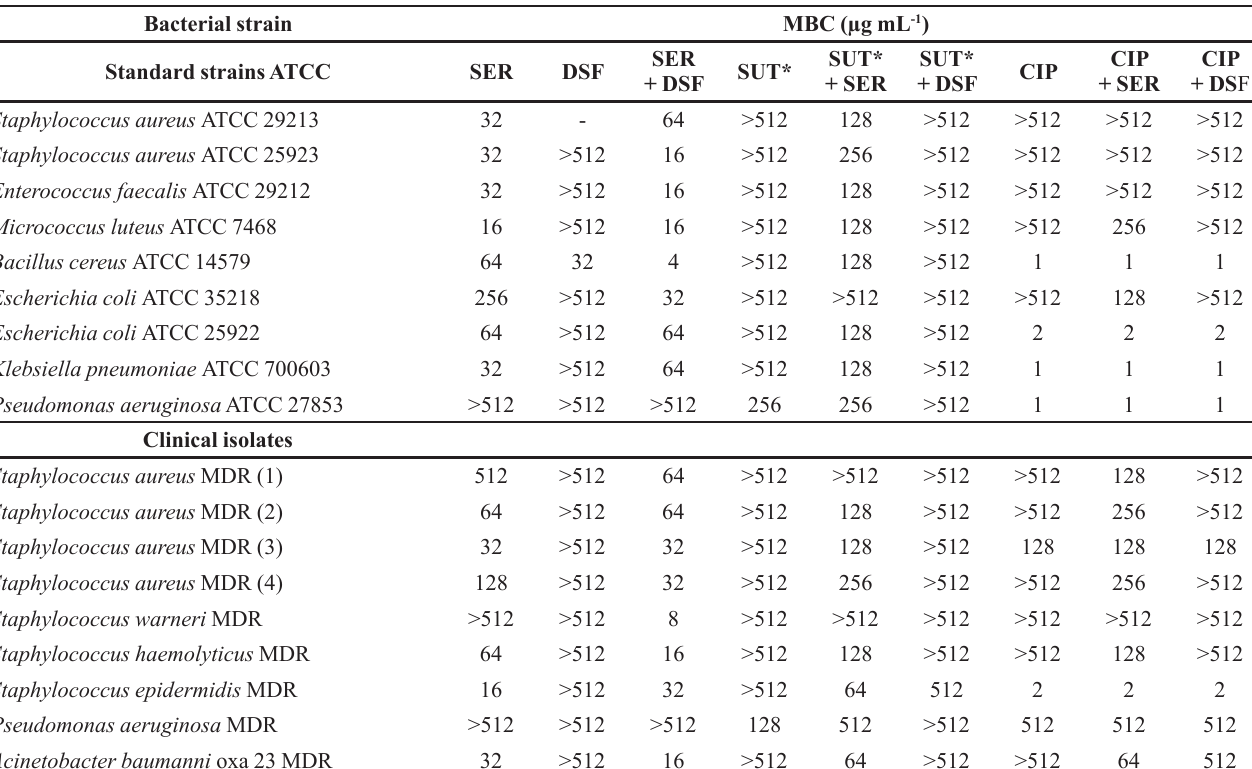
TABLE II – Minimum bactericide concentrations (MBC) of the sertraline and the disulfiram, sulfamethoxazole/trimethoprim and ciprofloxacin, alone and in combination against standard strains and clinical isolates Bacterial strain MBC (µg mL -1 ) Standard strains ATCC